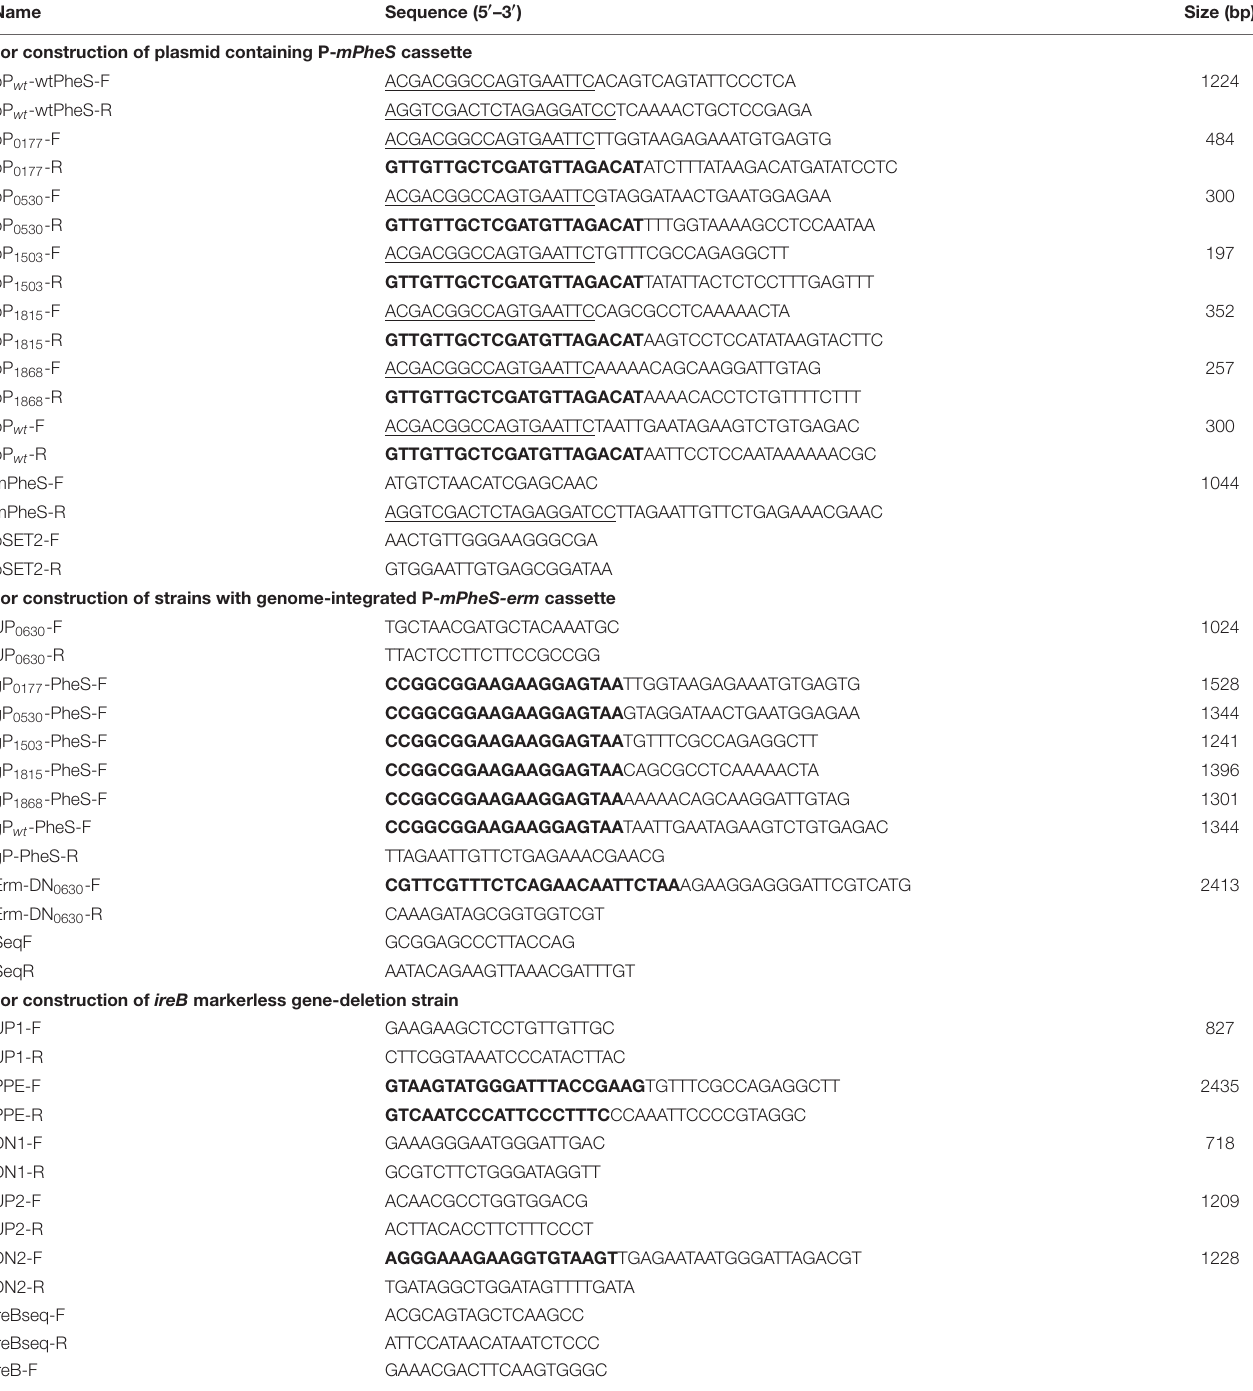
TABLE 1 | Primers used in this